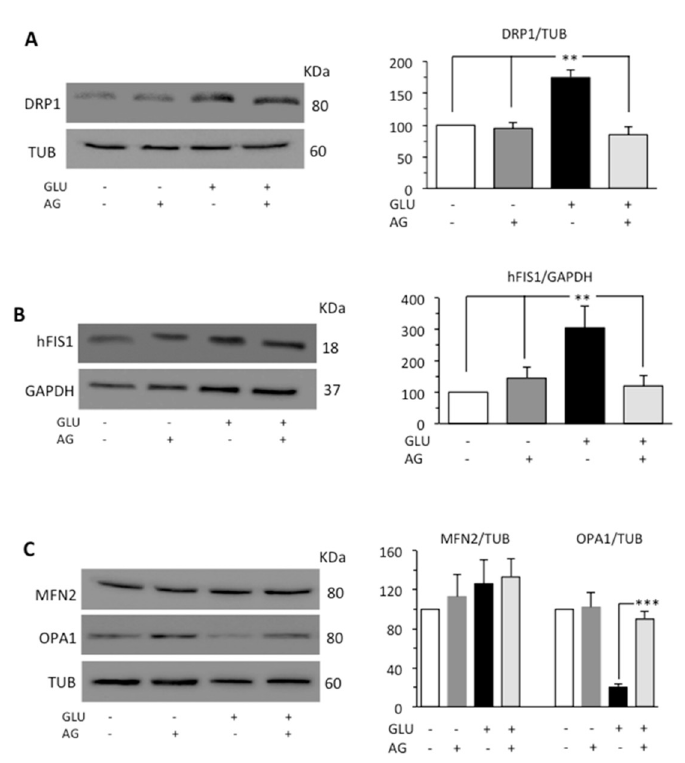
Figure 4. Western blot analysis of ( A ) DRP1 and ( B ) hFIS1, and ( C ) MFN2 and OPA1, involved in fission and fusion processes, respectively. Loading control was evaluated using anti-TUB or anti-GAPDH MAb. A representative experiment among the three is shown. Bar graphs on the right panel show densitometric analysis of the band density ratio of each protein relative to loading control. Mean ± SD from three independent experiments is shown. ** p ≤ 0.01 and *** p ≤ 0.001.